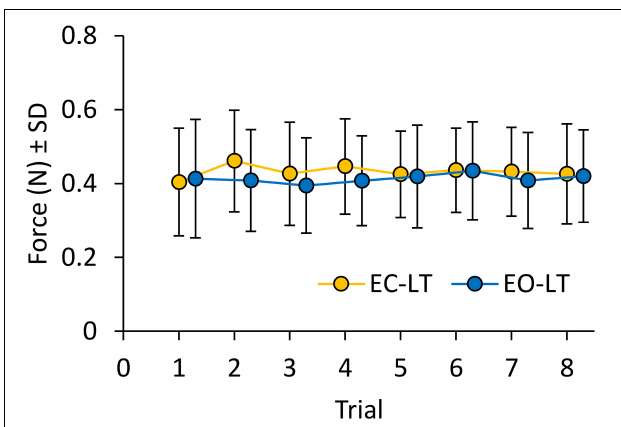
FIGURE 8 | Force applied on the touchpad during trials (means of all subjects). Force was not different between EC-LT (yellow symbols) and EO-LT (blue symbols). In both conditions, the force never exceeded1 N and remained constant across